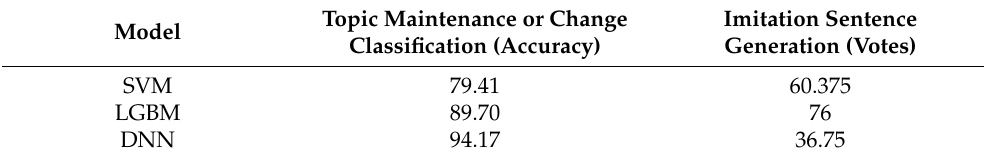
Table 3. Performance evaluation results of each